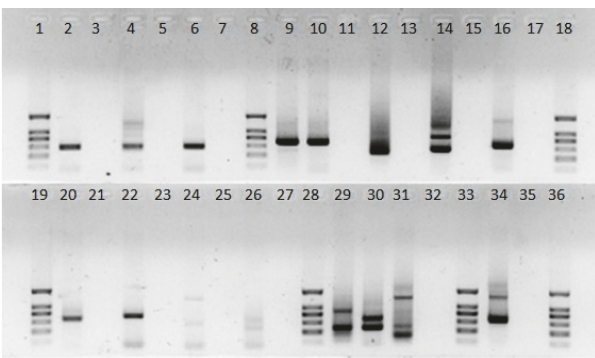
Figure 1: Individual primer pairs testing. ( 1, 8, 18, 19, 28, 33,